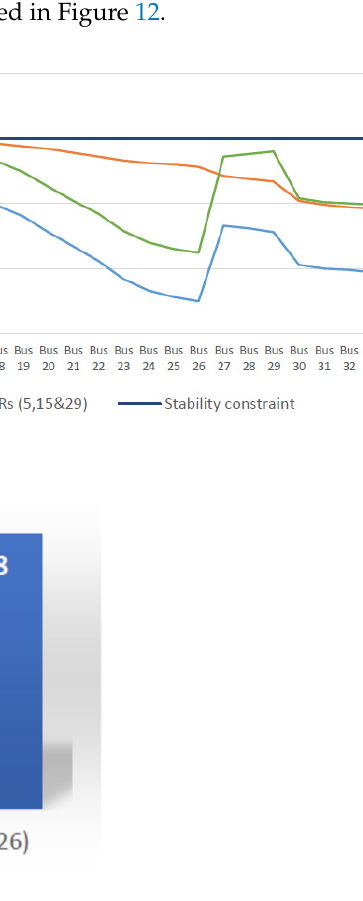
Table 2. Results comparison in terms of the system smallest eigenvalue, and network losses reduc- tion percentage.